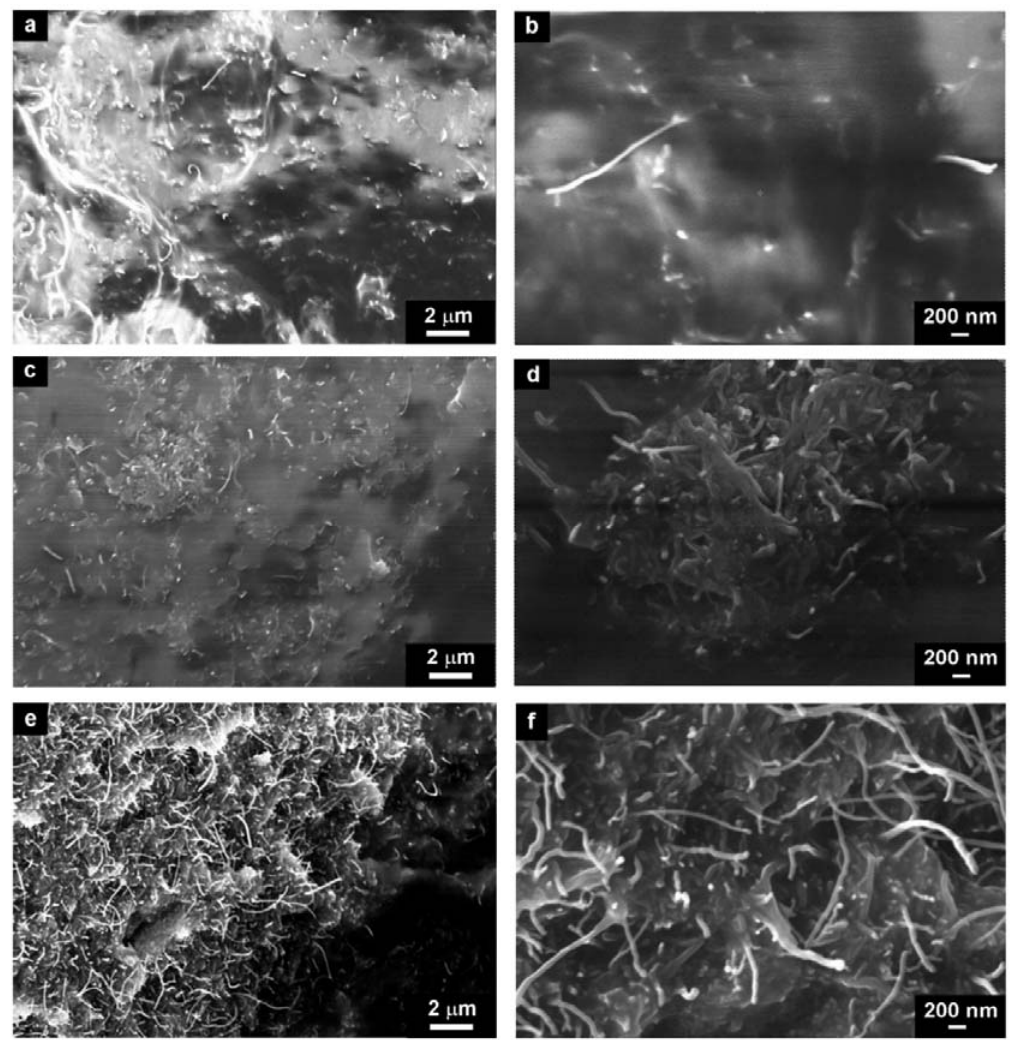
Figure 5. SEM micrographs of CNT  DBSA/silicone composites with